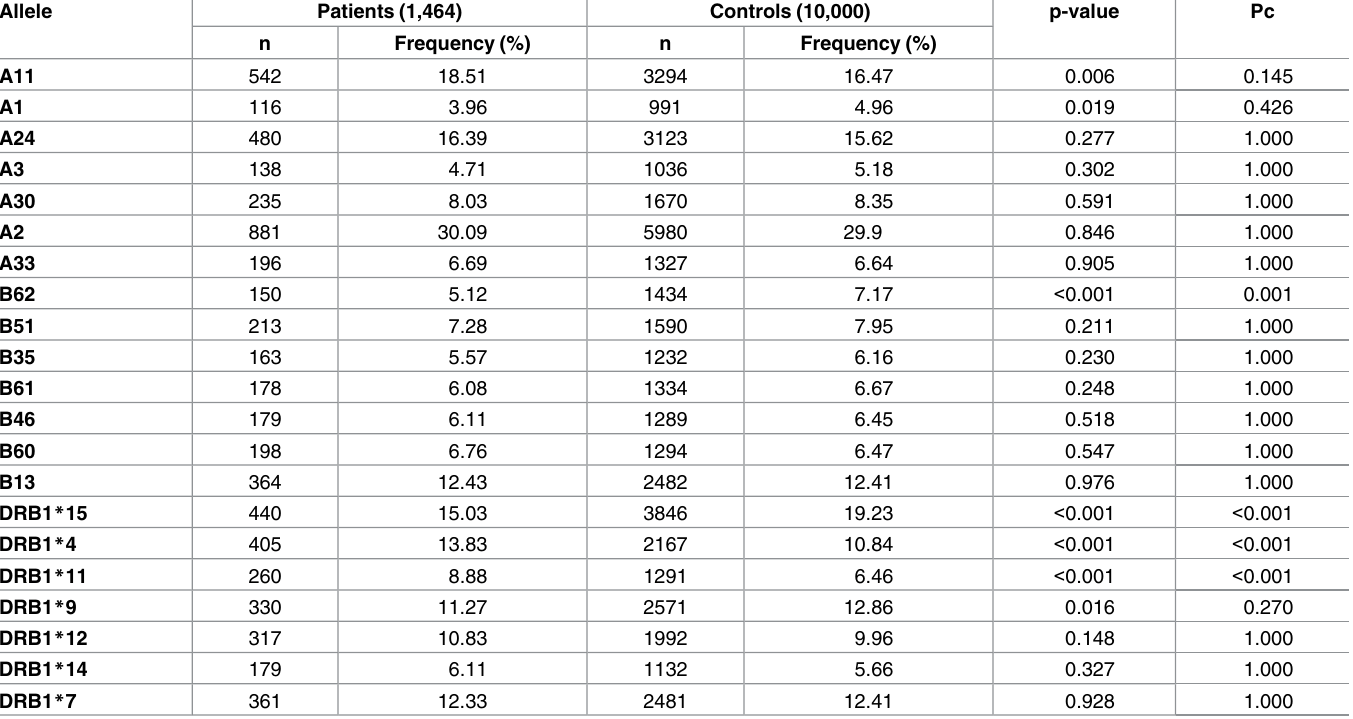
Table 1. The seven most frequent alleles of HLA-A, -B and -DRB1 loci. Allele Patients (1,464)